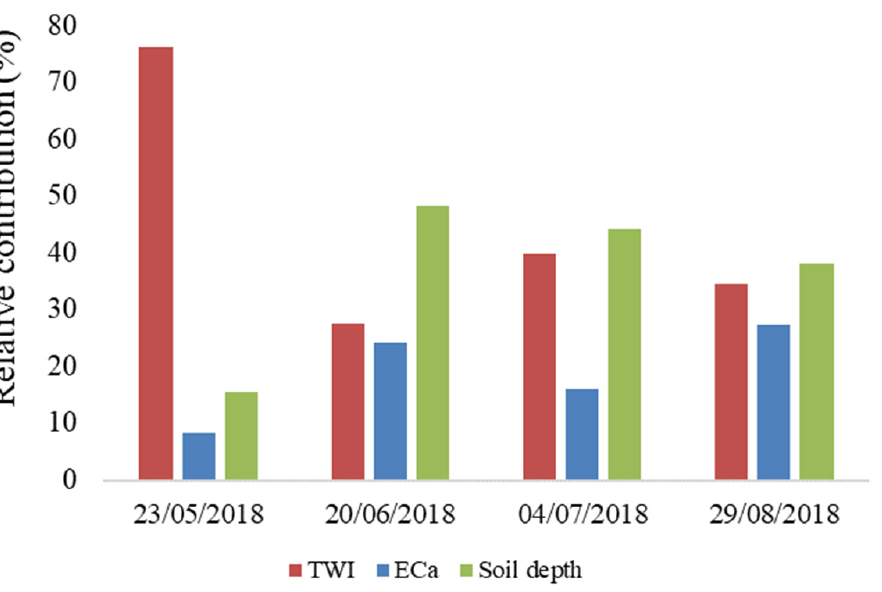
Figure 4. Relative contribution of soil and terrain variables to Ψ stem at fruit set (23 May 2018), bunch closure (20 June 2018), veraison (4 July 2018) and harvest (29 August 2018). RMSE ranged between 0.06 at early season and 0.18 at the end of season. TWI is topographical wetness index and ECa is apparent electrical conductivity.